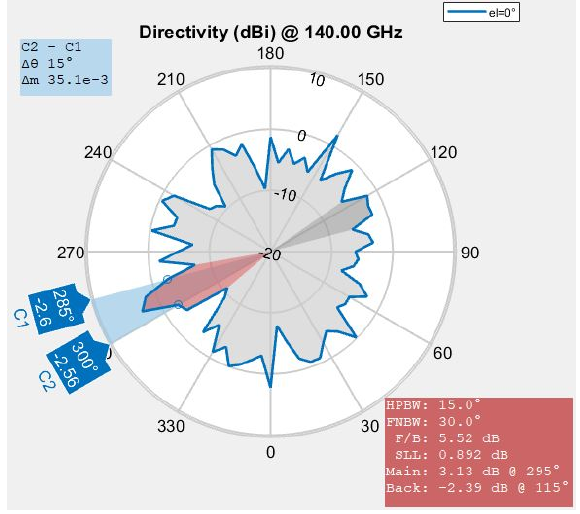
Figure 23. Azimuth pattern (directivity) of Minkowski fractal antenna.